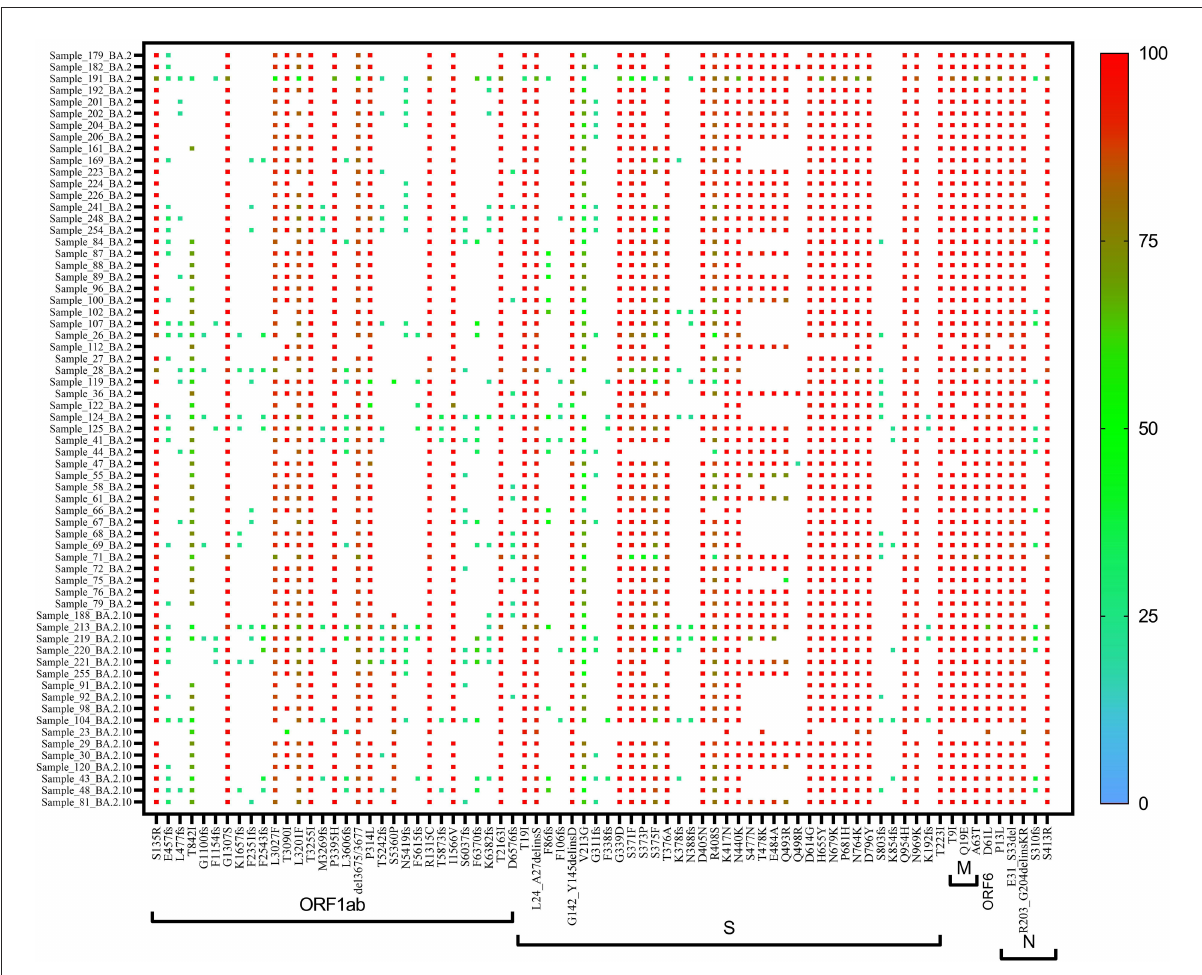
FIGURE6 Heat map of Omicron (BA.2 and derivative)